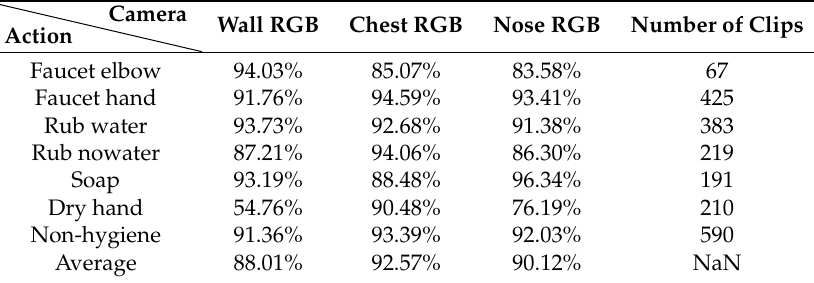
Table 1. Classifier accuracy for all three camera views; seven